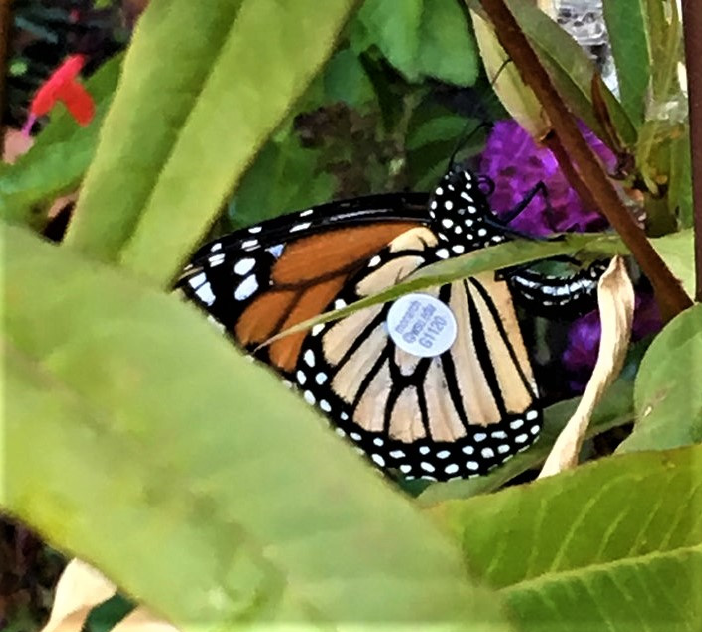
Figure 5. G1120, a female monarch reared and released in Talent, Oregon on 14 September 2019 by Belinda Vos and photographed 40 days later on 24 October 2019 ovipositing on backyard milk- weed in Palo Alto, California, after migrating 537.5 km. Photo by Karen Krimmer Easton. Table 2. Release, recovery, distance, direction and lifespan data for monarchs, captive-reared, tagged and released in the PNW during 2017. OS = overwintering site. Santa Cruz overwintering sites: LF = Lighthouse Field State Beach, NB = Natural Bridges State Beach, ML = Moran Lake.